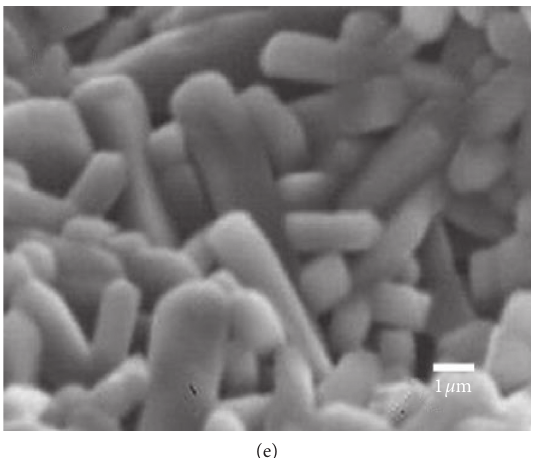
Figure 11: Scanning electron micrographs of 3:2 mullite. Specimen was sintered at 1600 ° C, cold uniaxially pressed, and thermally etched: (a) KA0h, (b) KA0.5h, (c) KA3h, (d) KA6h, and (e)